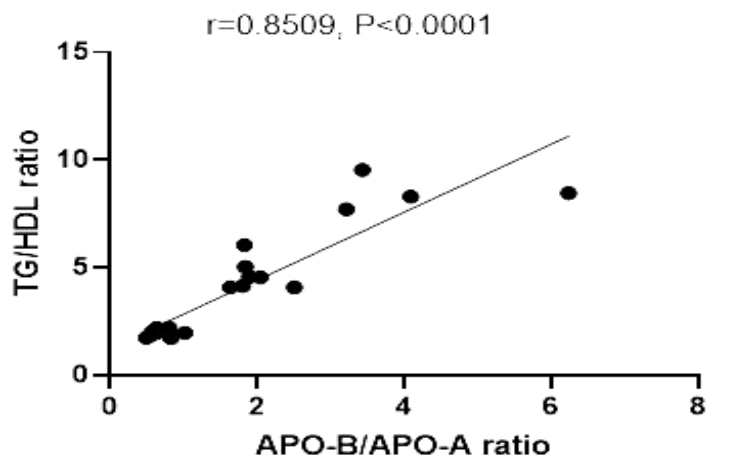
Figure 10. Correlation of TG/HDL ratio, and Apo B/Apo A. r= correlation coefficient. p = value of statistical statistical significance.